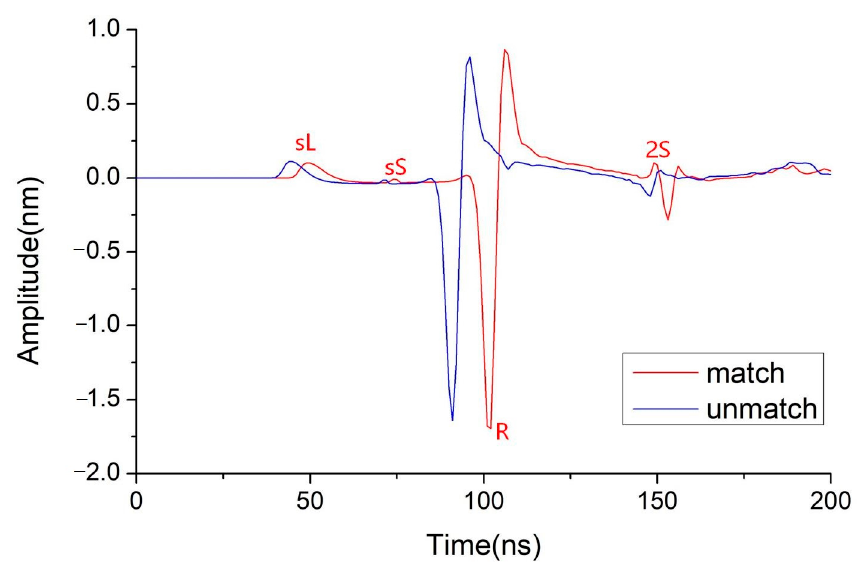
Figure 4. Typical RLUT signal: the ring radius R matches the layer thickness h vs. R unmatches h . Only when the calculated h simultaneously satisfies Equations (3) and (4), the h is regarded as a true value. For the second layer, as shown in Figure 3c, Equation (3) can be written as: According to Snell’s law: